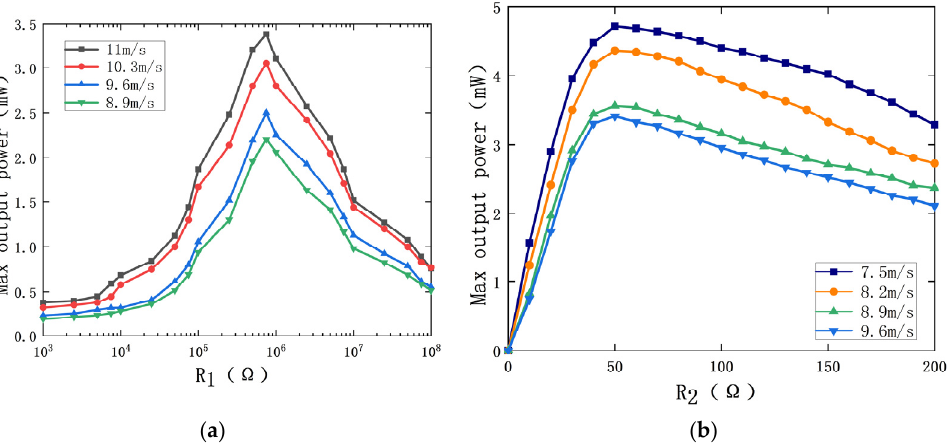
Figure 7. The effect of load resistance on the MPEGEH output power at different wind speeds: ( a ) effect of R 1 on the PEH output power; ( b ) effect of R 2 on the EEH output power.